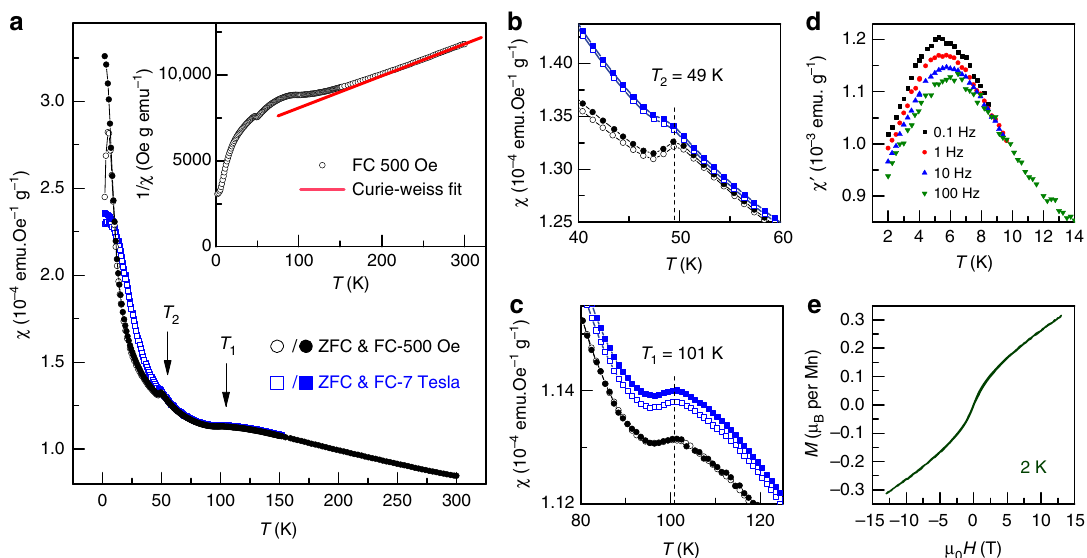
Fig. 2 Magnetic properties of the perovskite-type Mn 2 O 3 . a Temperature dependence of DC magnetic susceptibility measured in the fi eld of 500 Oe with both the zero- fi eld-cooling (ZFC) and fi eld-cooling (FC) modes. This curve distinctly demonstrates two magnetic transitions at T 1 = 101 K and T 2 = 49 K. The inset shows a Curie – Weiss fi t of the paramagnetic susceptibility. b , and c shows an effect of applied magnetic fi eld on the above-mentioned magnetic transitions. While the transition at T 2 is apparently suppressed by application of a 7 T fi eld, the transition at T 1 is very weakly affected by 7 T fi eld. d AC magnetic susceptibility as a function of temperature. The frequency dependent peak around 5 K suggests a short-range ordered magnetic state. e The M – H curve at 2 K showing no saturation of magnetization up to 13